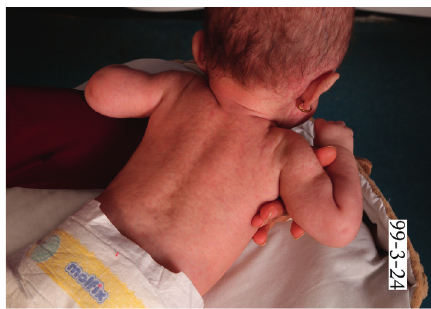
Figure 2: Multiple erythematous/hyperpigmented macules.